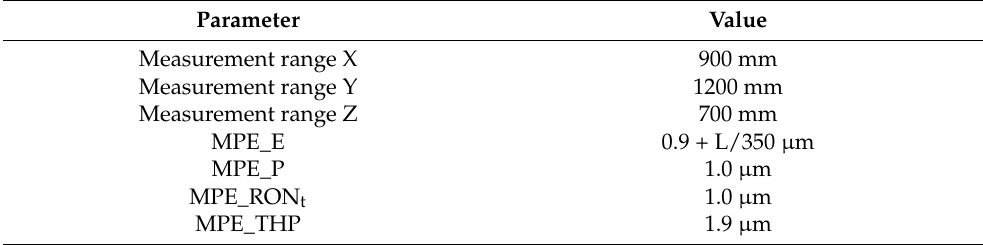
Figure 3. Sample clamping method used in the PRISMO Navigator coordinating machine. Table 3. Parameters of the ZEISS PRISMO Navigator coordinate measuring